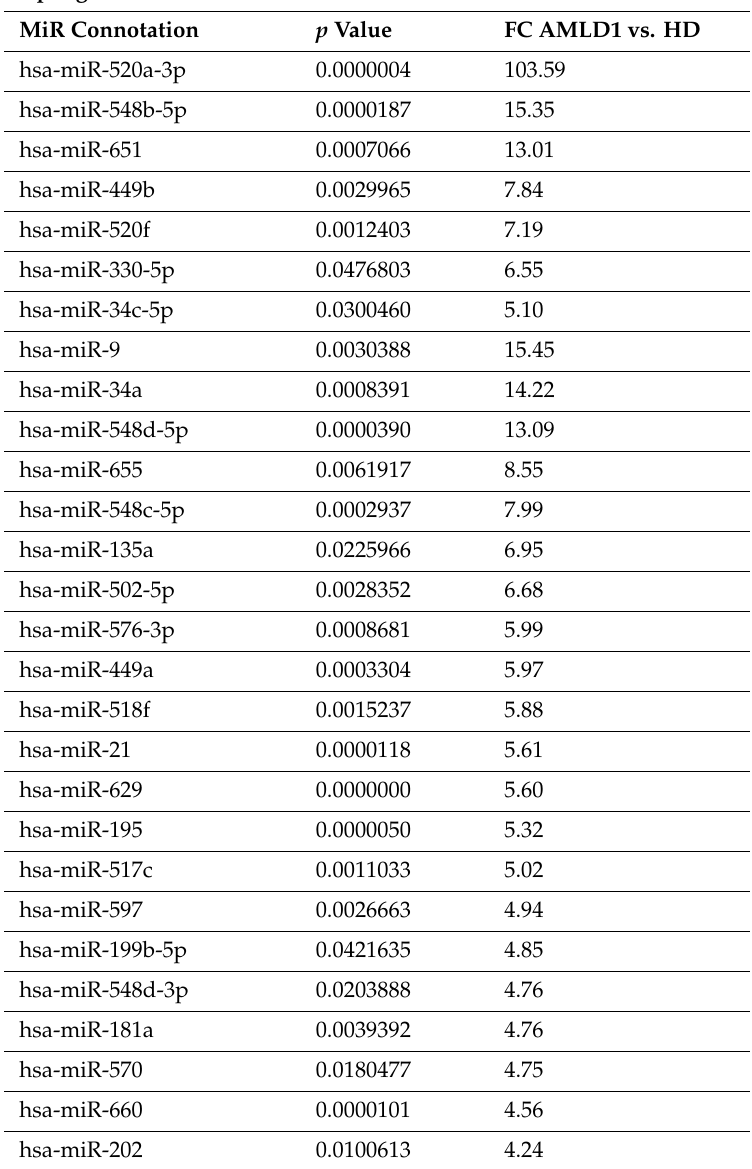
Table 1. Bone marrow circulating miRNAs di ff erentially expressed in AML newly diagnosed compared to healthy